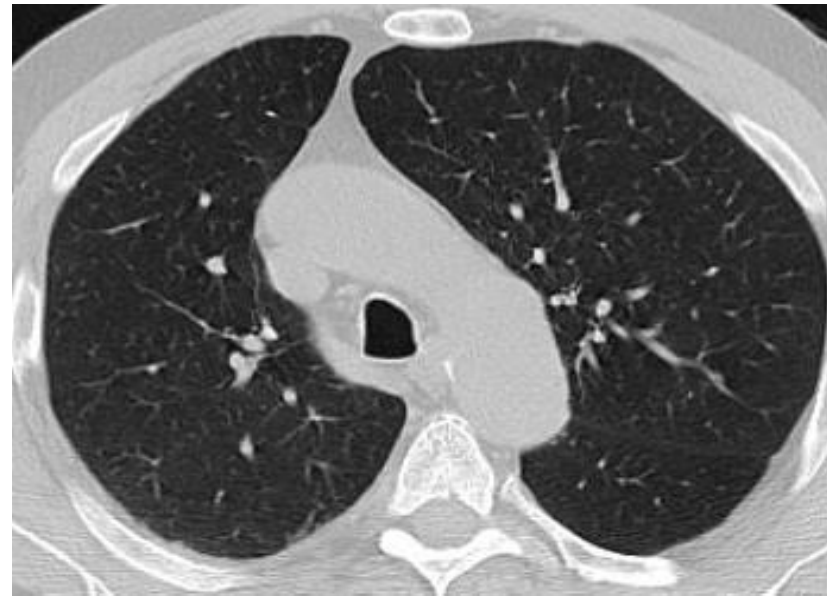
Figure 2. Computed tomography of the chest before immunotherapy.